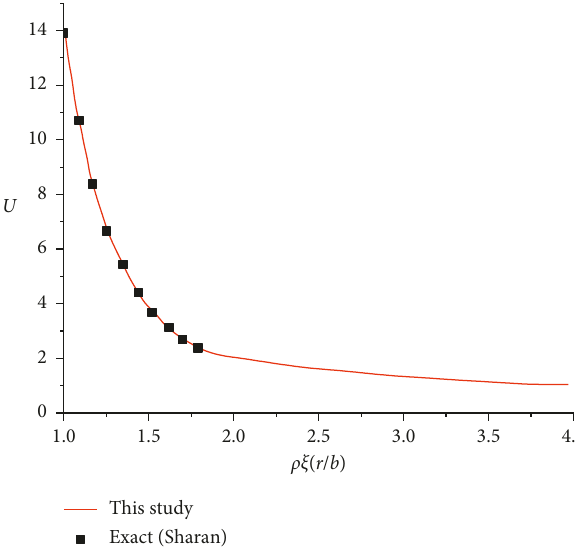
Figure 5: Comparison between dimensionless displacement and exact displacement for Hoek–Brown rock